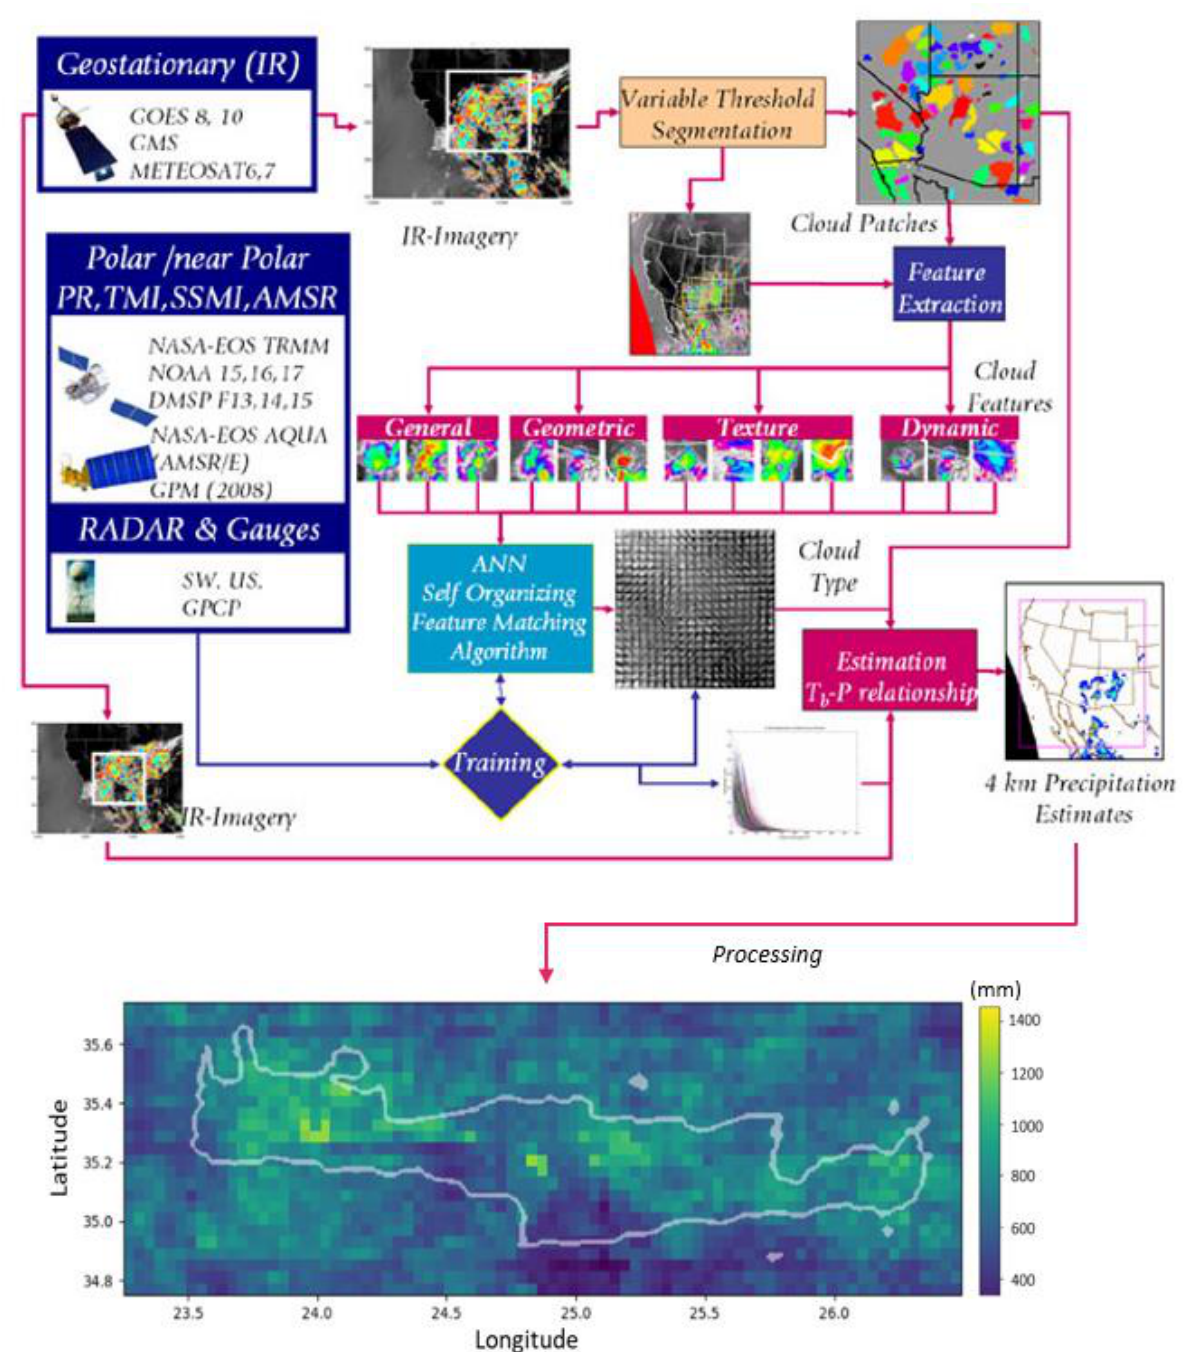
Figure 2. Data-processing pipeline (adapted from: http://chrs.web.uci.edu/SP_activities01.php, accessed on 1 April 2021). Average annual precipitation (mm) over the island of Crete for the study period 2009/10–2017/18 obtained from the PERSIANN-CCS satellite database.